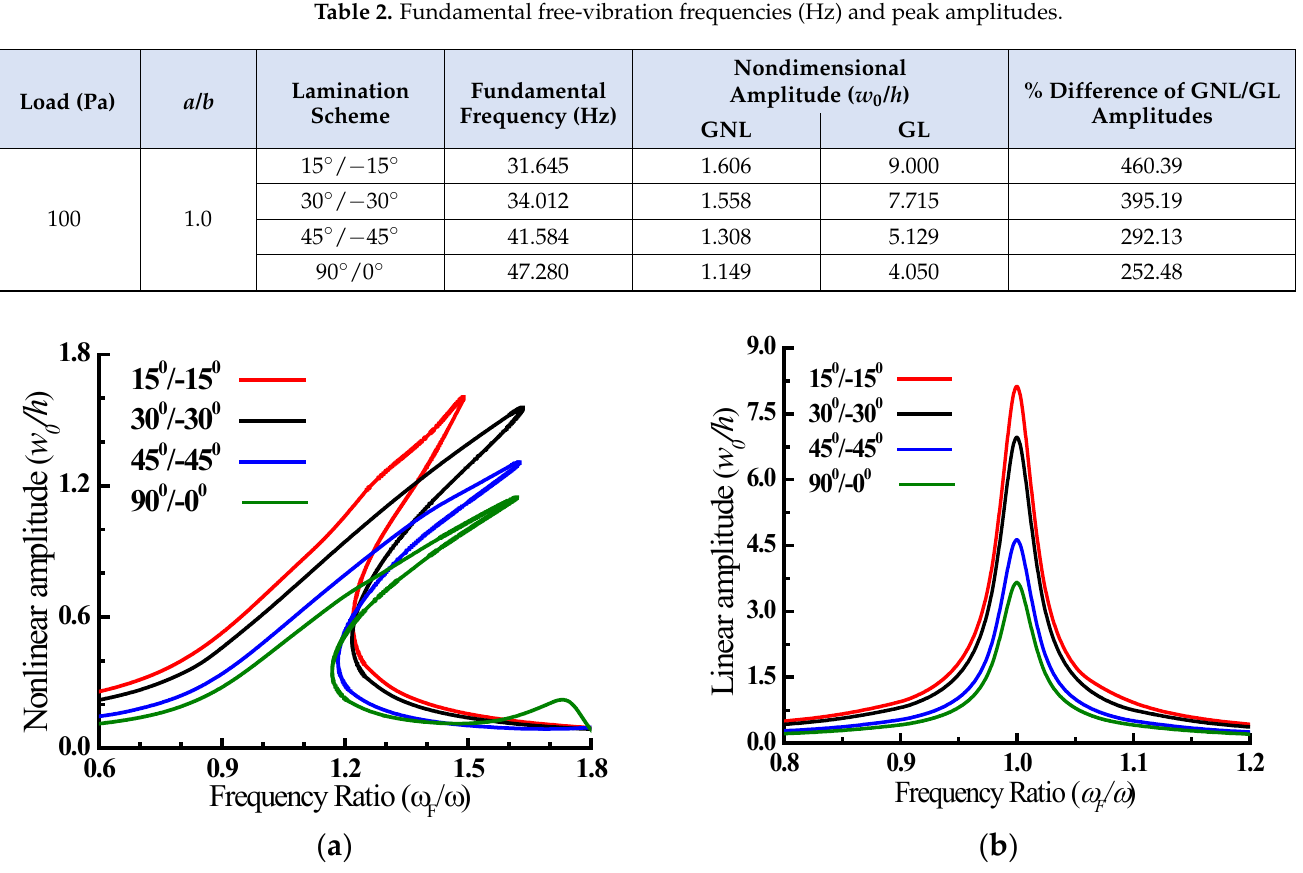
shows that forcing frequency ratio corresponding to the nonlinear peak displacement falls with the increasing fiber angle, with ω F / ω = 1.64, 1.558 and 1.308 for a two-layered angle-ply